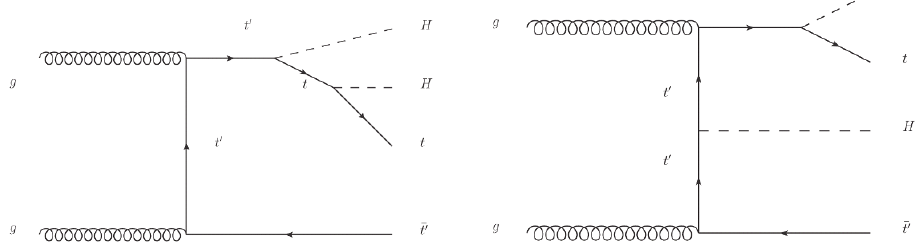
Figure 2 . Representative Feynman diagrams for the process pp ! t 0 thh . The diagram on the right changes sign when the sign of Y t 0 t 0 h is (cid:13)ipped, while the diagram on the left does